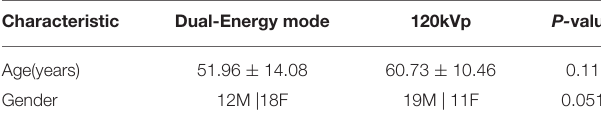
TABLE 2 | Baseline characteristics.